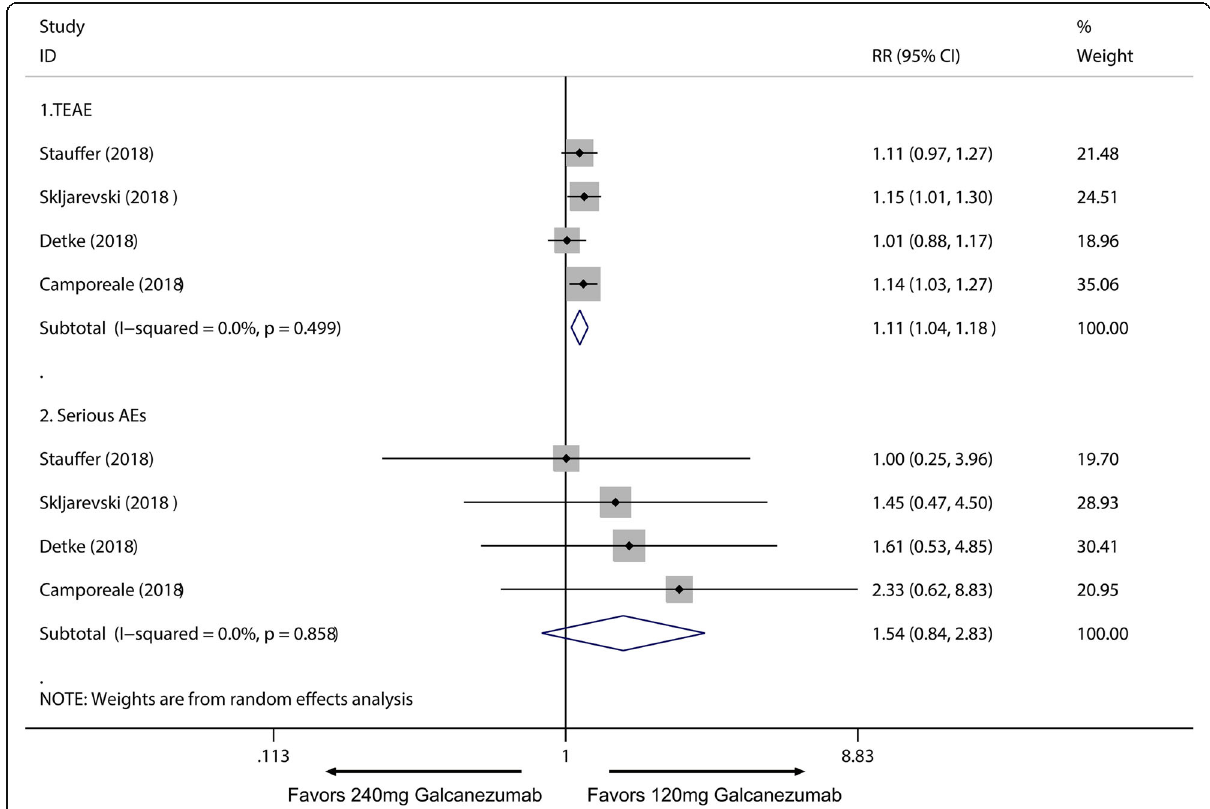
Fig. 9 Comparison of SAEs between 120 mg and 240 mg galcanezumab. RR relative